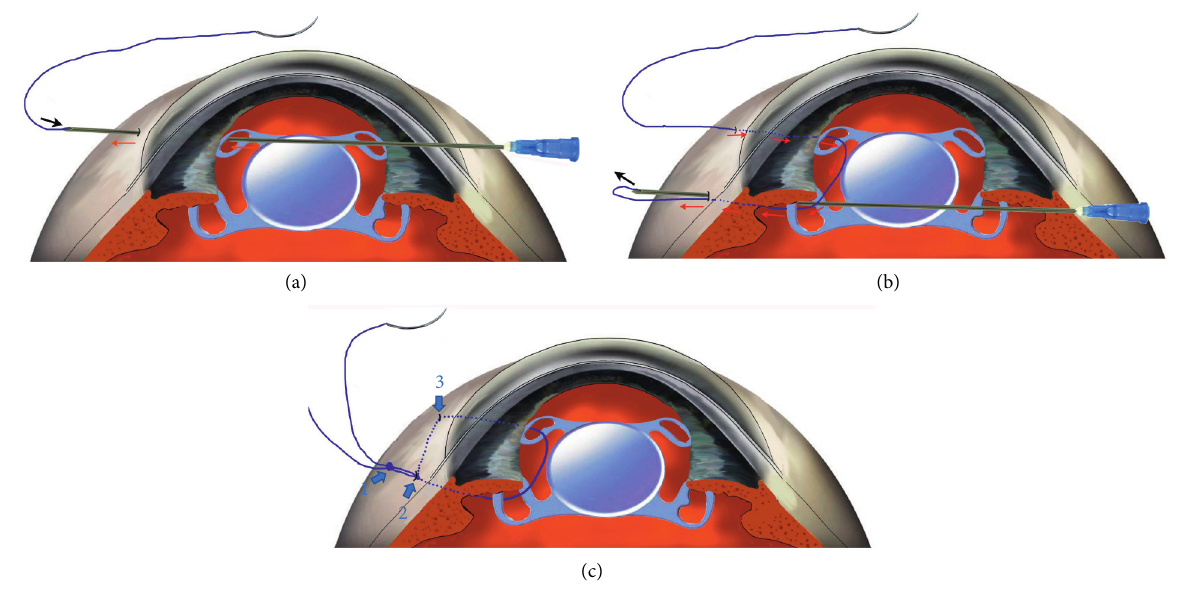
Figure 1: Schematic figure of the intraocular looping technique for four-point fixation (drawn by Haiying Jin). This figure is authorized to be published by the present journal to demonstrate the surgical procedures. (a) The looping needle is externalized from the first fixation point and loaded with an 8–0 polypropylene thread in its lumen (arrow). Red arrows show the needle path from the eyelet of the IOL to the sclerotomy. (b) After loading the thread, the looping needle is recoiled into the anterior chamber and passed through the following paths: the first eyelet of the IOL, the second eyelet of the IOL, and ab externo pass through the second sclerotomy (red arrows). The thread in the lumen of the needle is finally pulled out (black arrow). A suture loop is created passing through both eyelets on the same side. (c) After the intrascleral passing (arrow 3) of the thread from the first fixation site to the second fixation site, a double knot technique is performed for a flapless IOL fixation. The first overhand knot in the sclerotomy (arrow 2) is used for the IOL fixation. The second knot (1) is used to lead the ends of the threads for burying in the sclera.